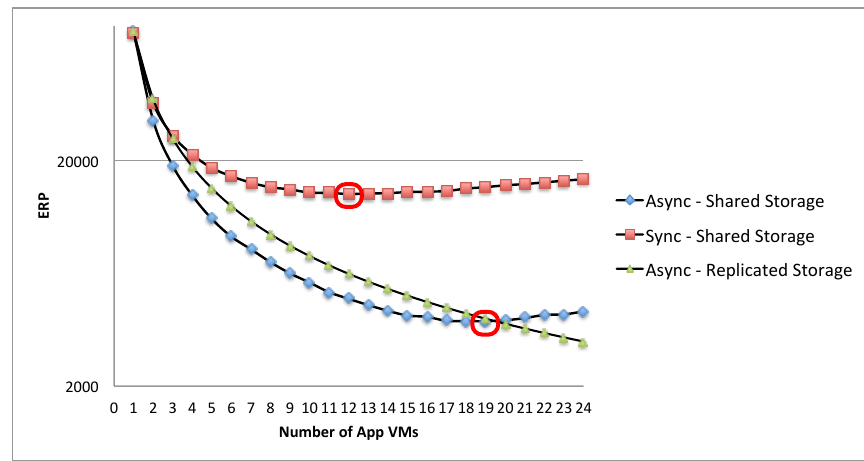
Figure 20. Analysis of the trade-off between total energy and execution